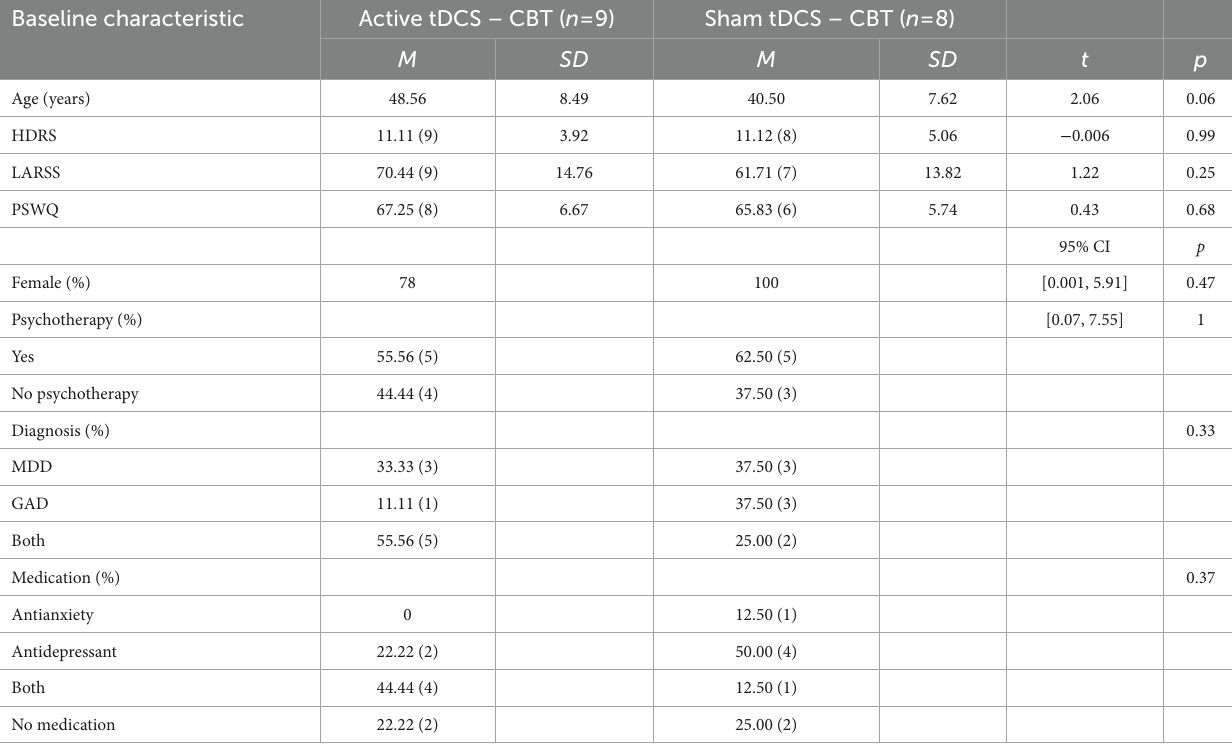
TABLE 1 Baseline demographic and clinical characteristics of patients in the active versus sham tDCS